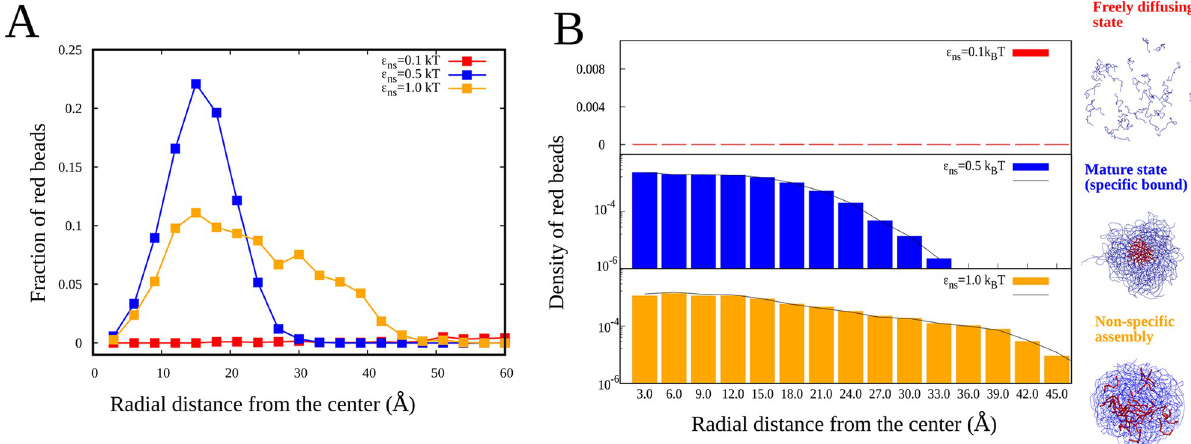
Fig 5. Spatial distribution of specific interaction sites. A) Fraction of red beads is each shell is plotted as a function of radial distance from the center of the cluster (blue and orange curves for self-assembled states) or the simulation box (freely diffusing state, redcurve). B) Density of red beads in each shell is plotted as a function of radial distance from the center.